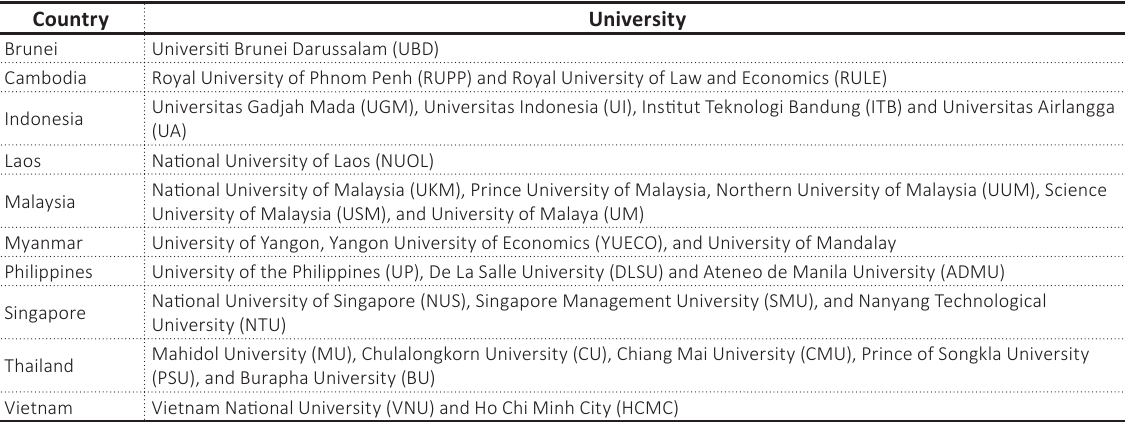
Table 4. Universities in ASEAN University Network